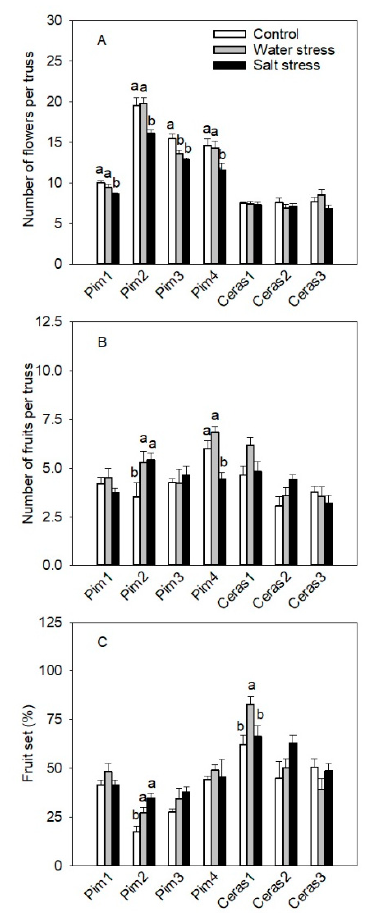
Figure 6. Number of flowers per truss ( A ), number of fruits per truss ( B ) and fruit set ( C ) in accessions Pim1, Pim2, Pim3, Pim4, Ceras1, Ceras2 and Ceras3 under control, water stress and salt treatments after 75 days of treatment Data are mean values ± SE for n = 8 plants. Within each accession, different letters indicate significant differences at p < 0.05 (LSD test). Analysis of two-way ANOVA is provided in supplementary material in Table S5. SE: Standard error.